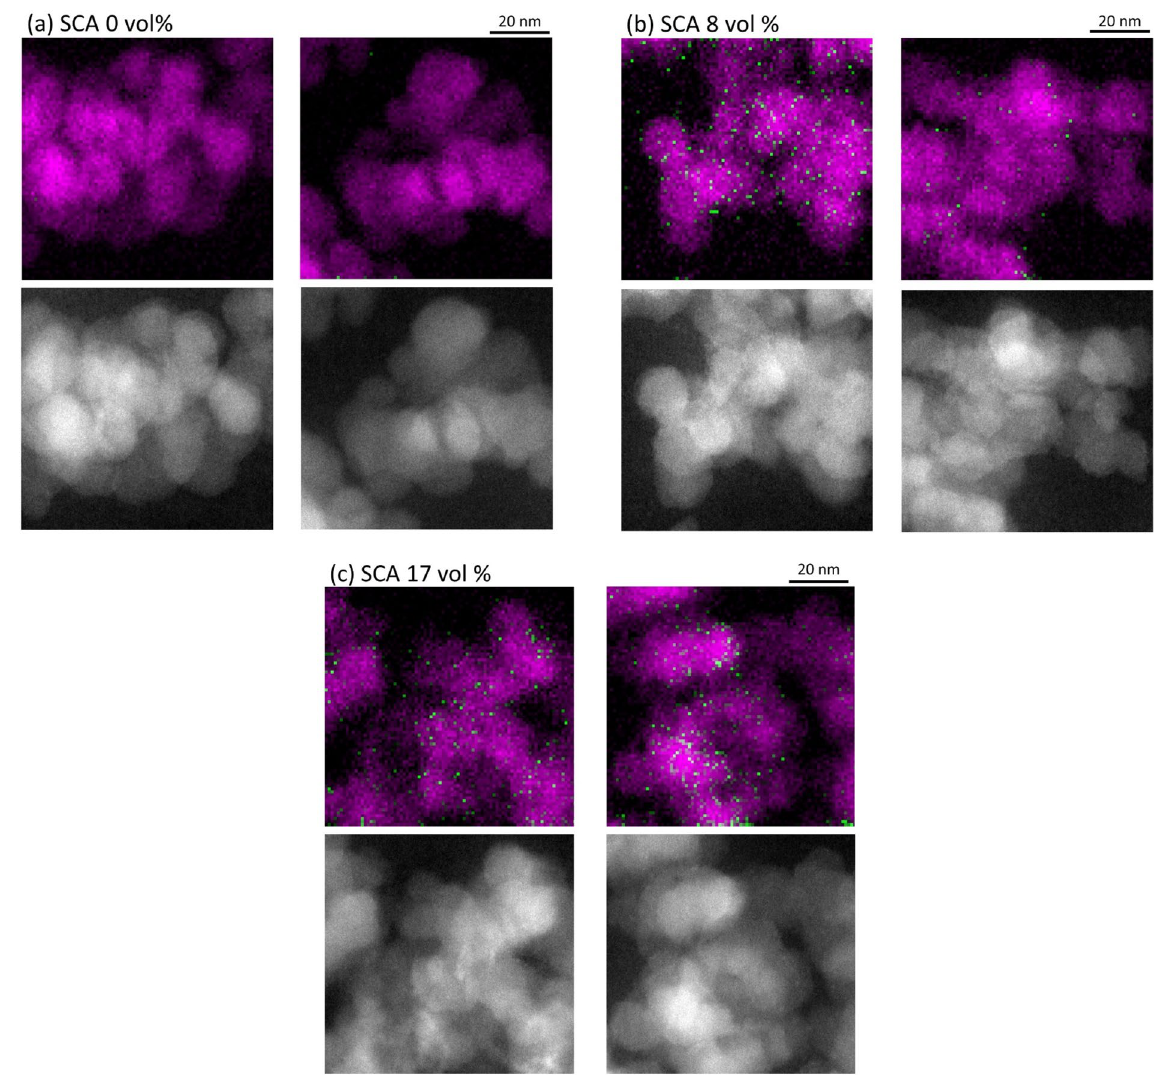
Figure 5. Chemical bonding maps (top) and ADF images (bottom) of silica-filled SBR containing (a) 0, (b) 8 and (c) 17 vol % SCA. Magenta regions and green dots correspond to the bonding states of silica and SCA,